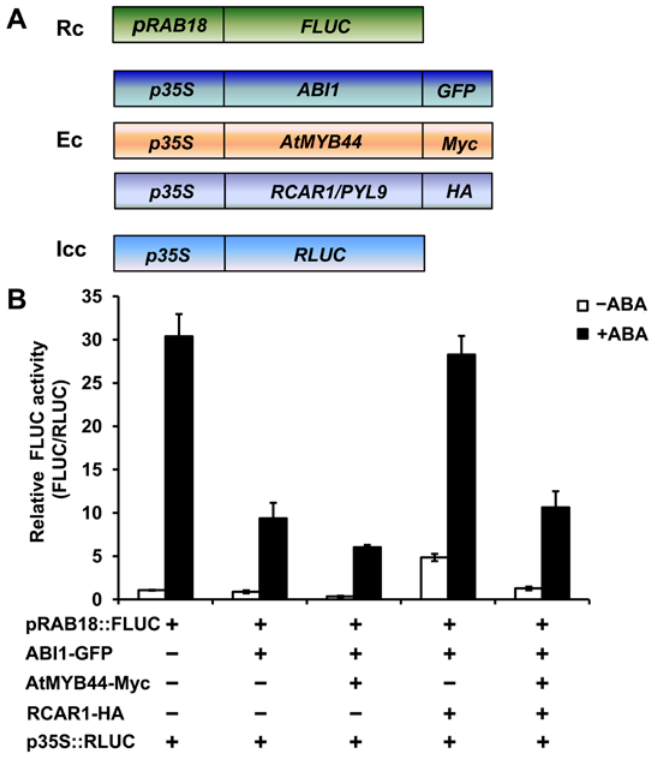
Figure 6. AtMYB44 likely reduces the inhibitory effect of RCAR1/PYL9 on ABI1 activity in vivo. ( A ) Schematic representation of reporter, effector and internal control constructs used in transactivation assay. Rc indicates Reporter construct; Ec indicates Effector constructs; Icc indicates Internal control construct; ( B ) AtMYB44 seems to reduce RCAR1/PYL9-mediated inhibition of ABI1 activity in protoplasts. pRAB18::FLUC , p35S::ABI1 - GFP , p35S::RCAR1/PYL9 - HA , and p35S::AtMYB44 - Myc plasmids were co-transfected into Arabidopsis protoplasts from the wild-type plants as the indicated combinations. RLUC was used as an internal control. After transfection, protoplasts were incubated for 5 h under light in the absence (open bars) or presence (filled bars) of 5 μM ABA, and luciferase activity was measured. Values are mean ± SD of three independent